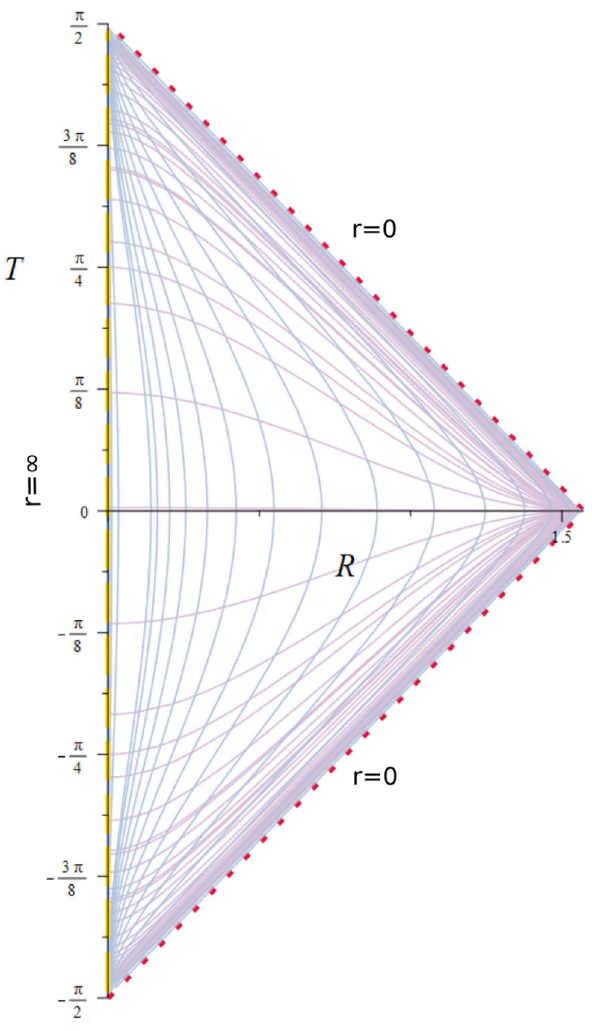
Fig. 1 Carter–Penrose diagram of a generic hyperscaling violating Schrödinger spacetime with θ > 0 and z > 1. The lilac and blue lines are the constant u and r null geodesics respectively represented in the compactified space. The dotted red line corresponds to the spatial infinity r = ∞ and the dashed yellow line belongs to the unavoidable singularity at r = 0 which maps to a null surface in this representation